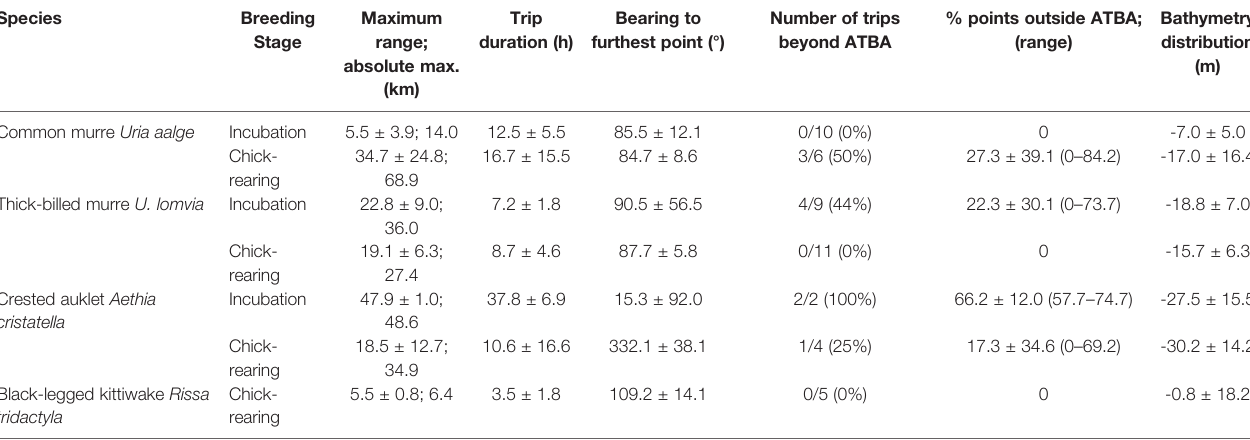
TABLE 2 | Summary of trip metrics per categories of species and breeding stage.